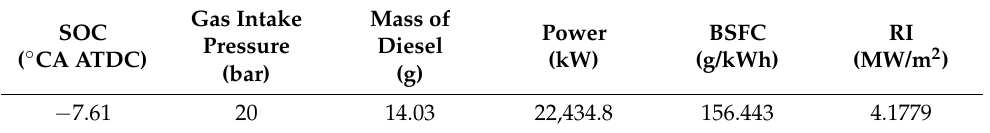
Table 6. RSM optimization